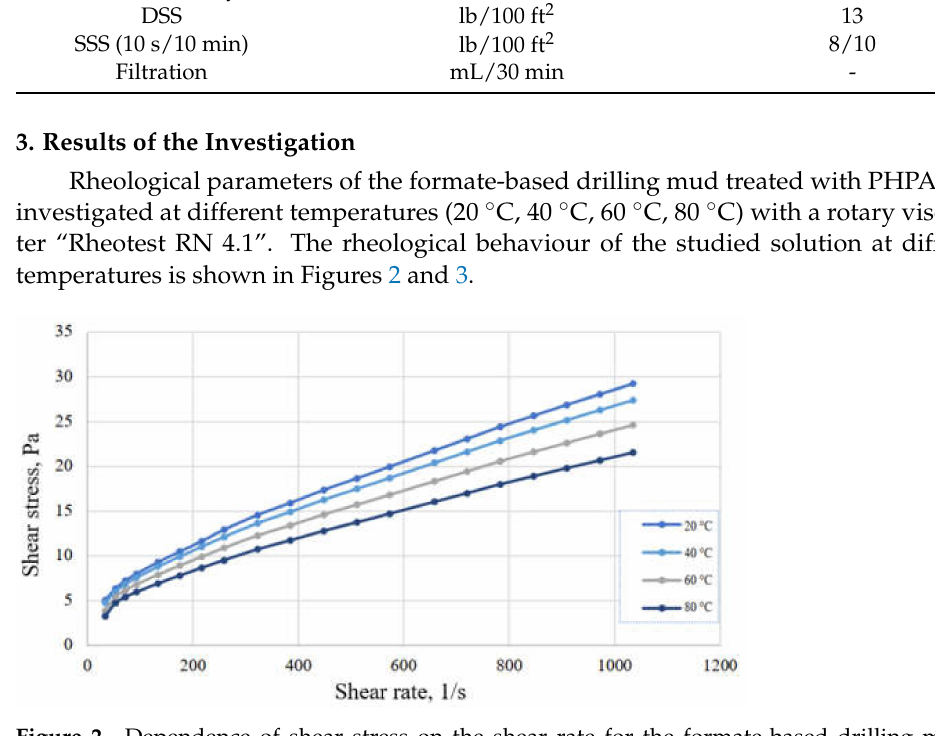
Figure 2. Dependence of shear stress on the shear rate for the formate-based drilling mud at different